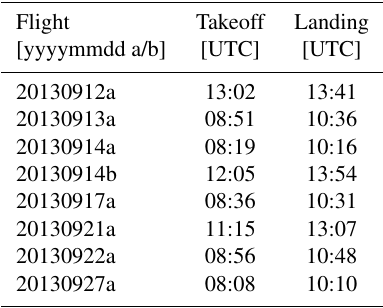
Table 1. Hygroscopicity κ and density ρ of each considered aerosol particle compound.